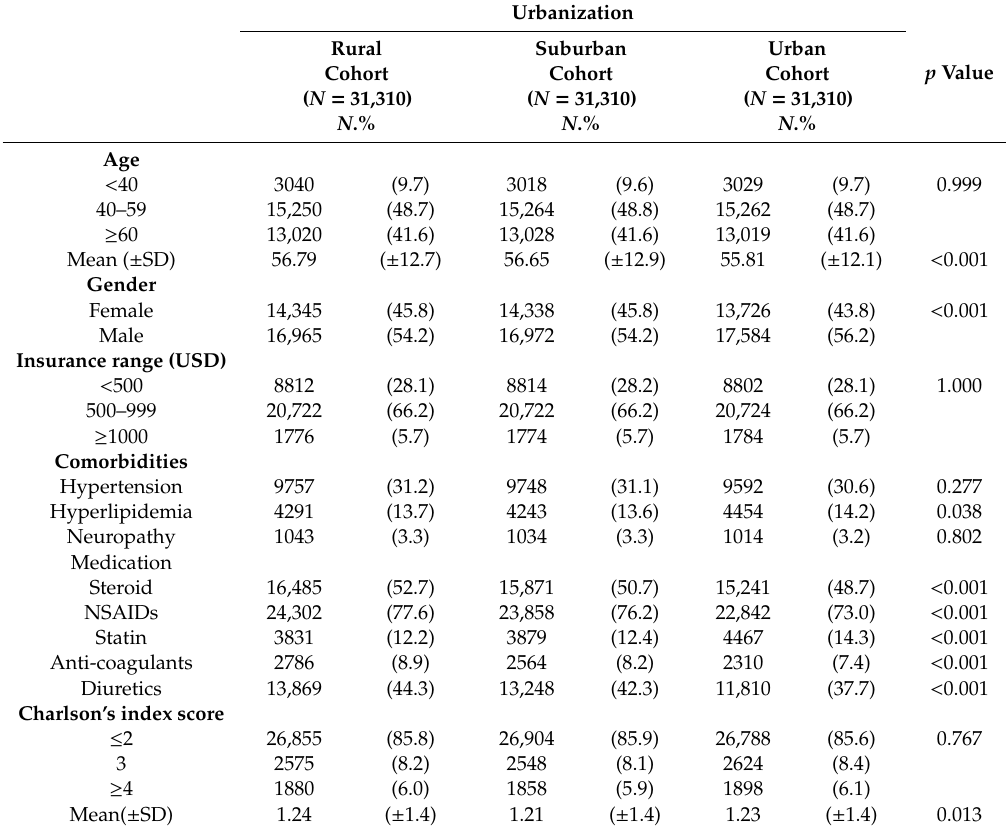
Table 1. Demographic characteristics of matched study cohorts by the level of